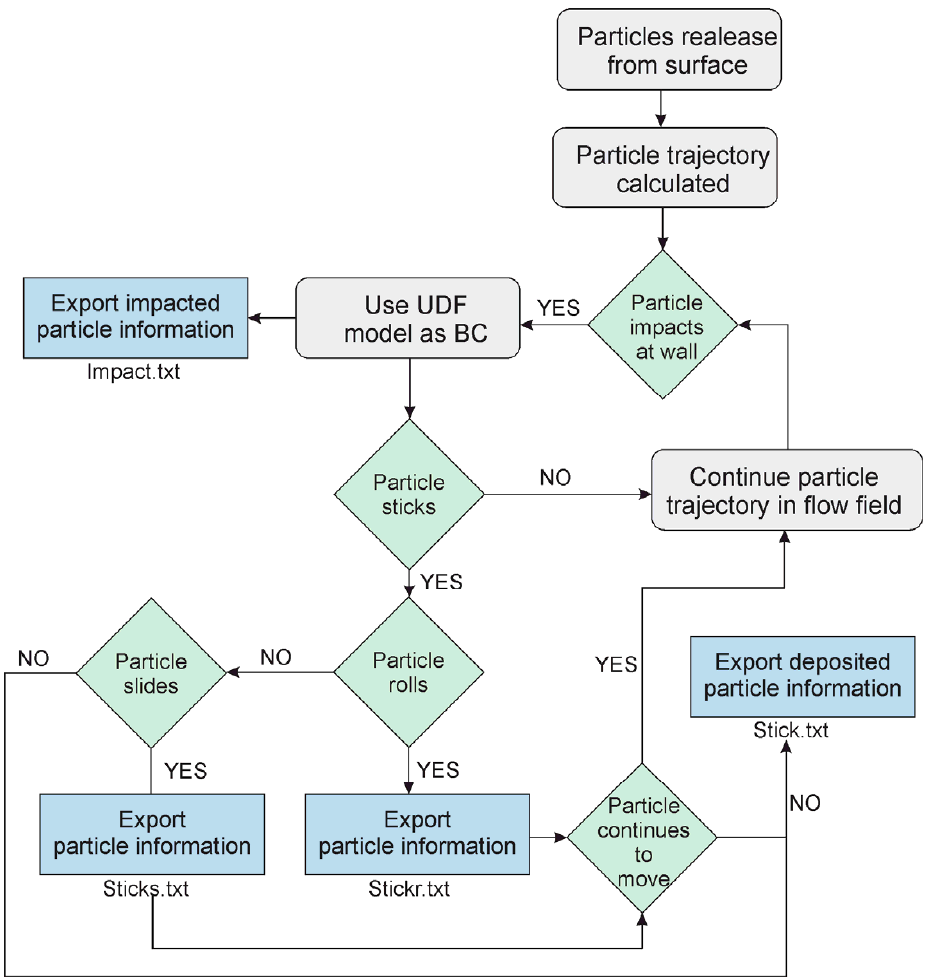
Figure 4. Description of particle behavior—proposed methodology to track particle deposition and detachment.